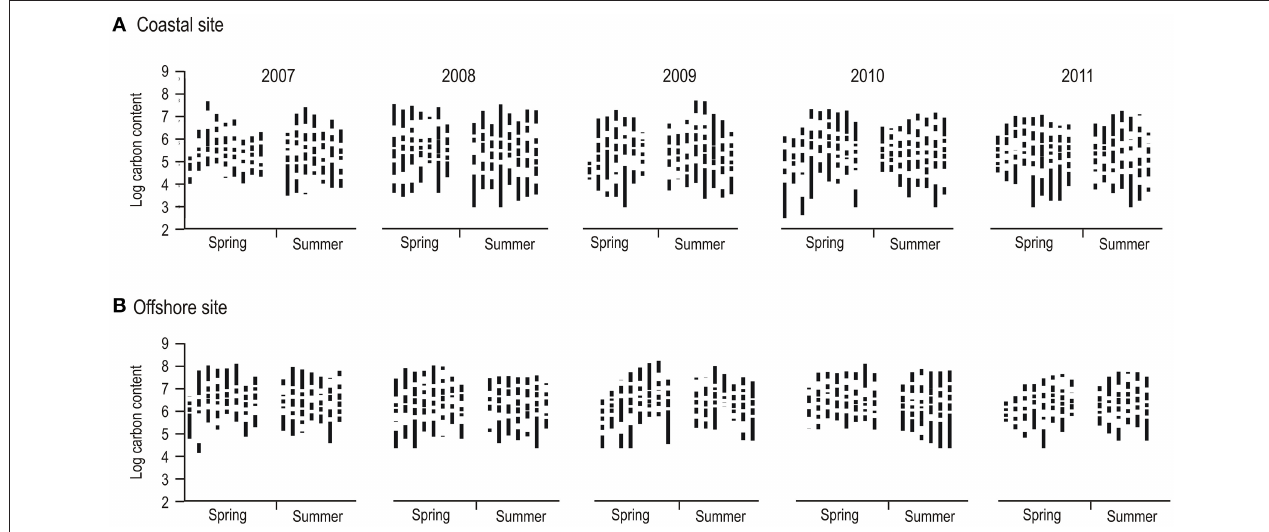
FIGURE 1 | Phytoplankton cross-scale structure during spring and summer blooms at a coastal (A) and offshore (B) site between 2007 and 2011 in the Baltic Sea. Shown are stacked biomass aggregation groups (black bars; ranges from lowest to highest biomass within a group) separated by gaps (white bars; no biomass present between aggregation groups) during repeated (8–9) sampling events within